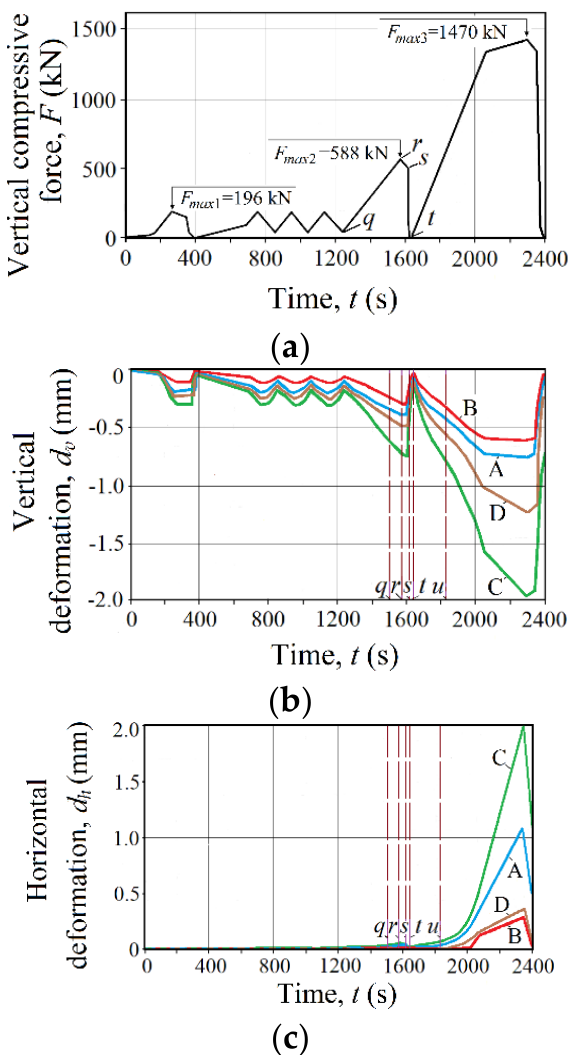
Figure 6. Specimen behavior under load: ( a ) variation in compressive force, F ; ( b ) specimen vertical deformation, d v ; ( c ) specimen horizontal deformation, d h , with time, t , as measured with electrical LVDTs at the center of each specimen lateral face—A, B, C, and D—during the test.